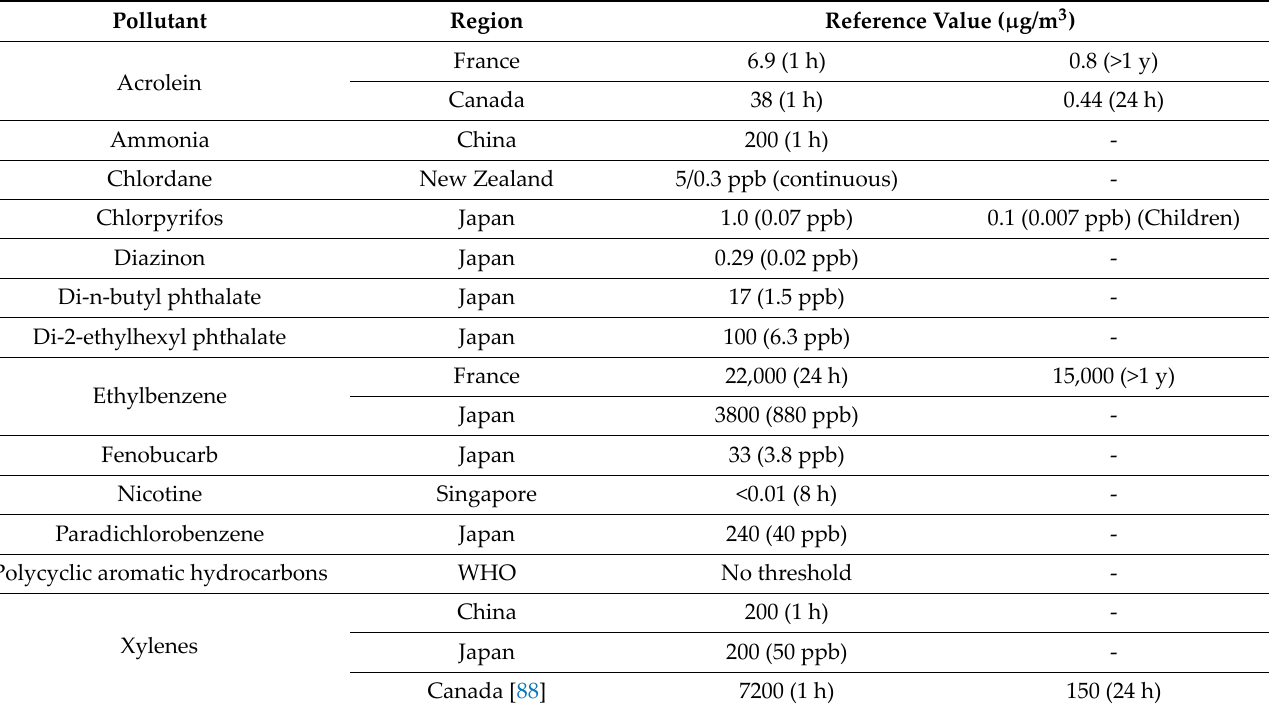
Table 22. Reference values for organic pollutants.